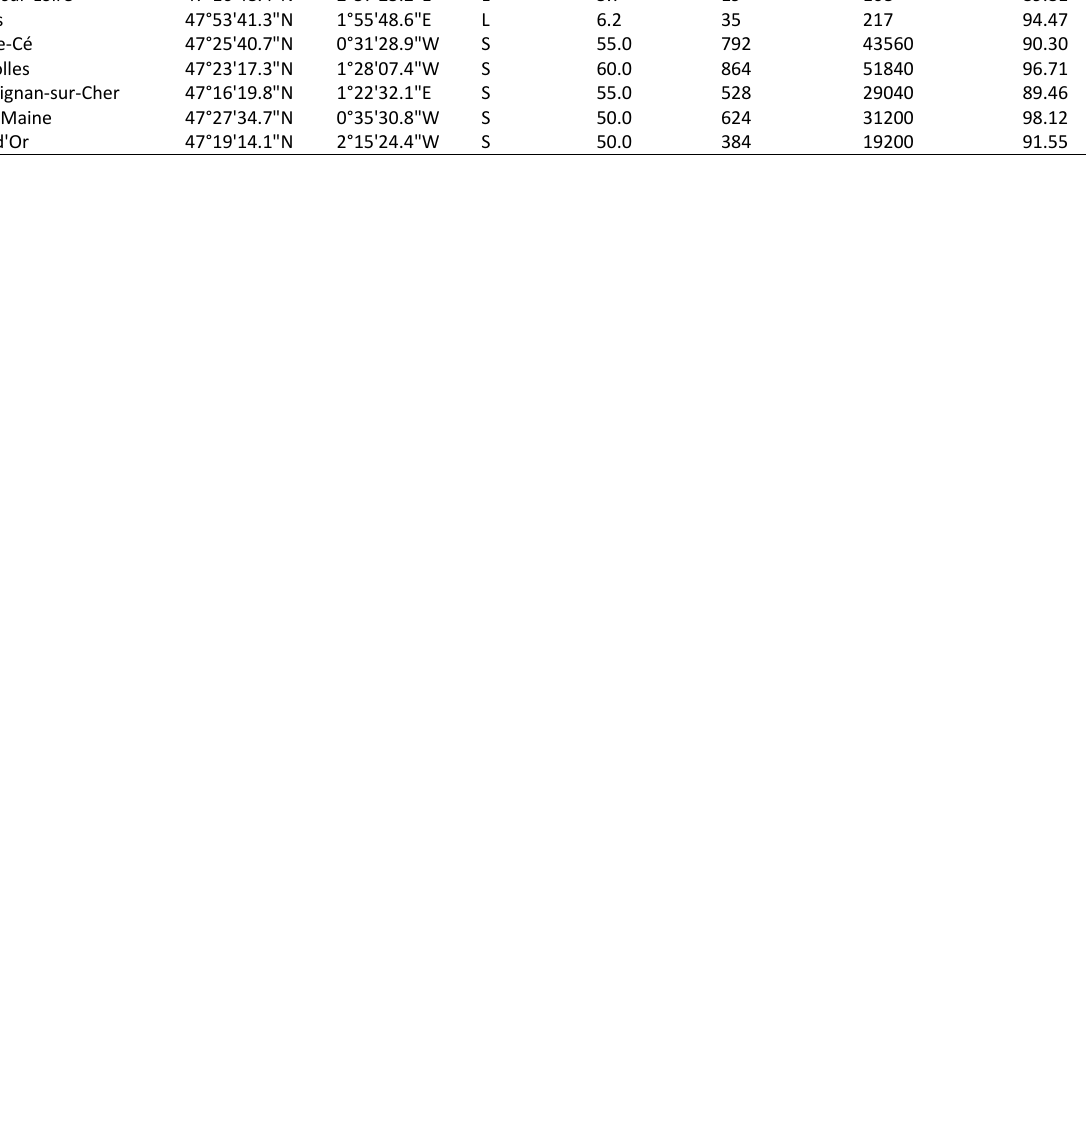
Germination (percentage)